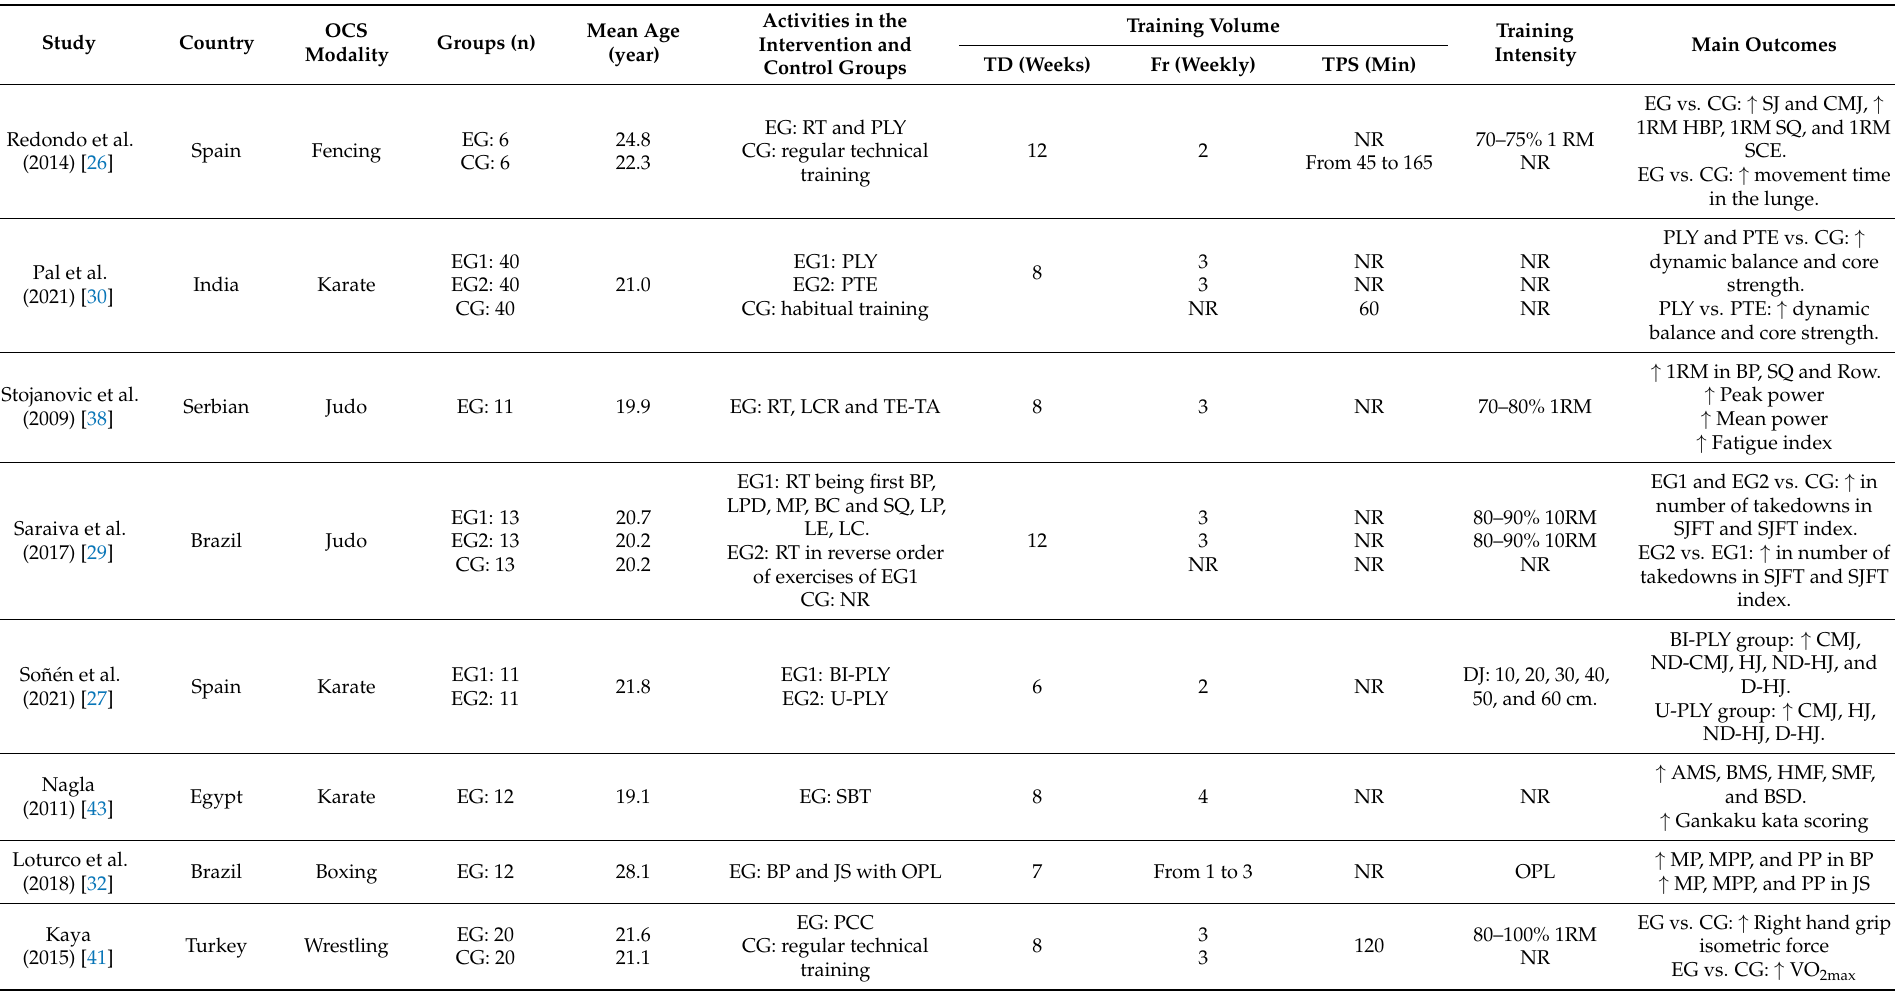
EG vs. CG: ↑ Right hand grip isometric force EG vs. CG: ↑ VO